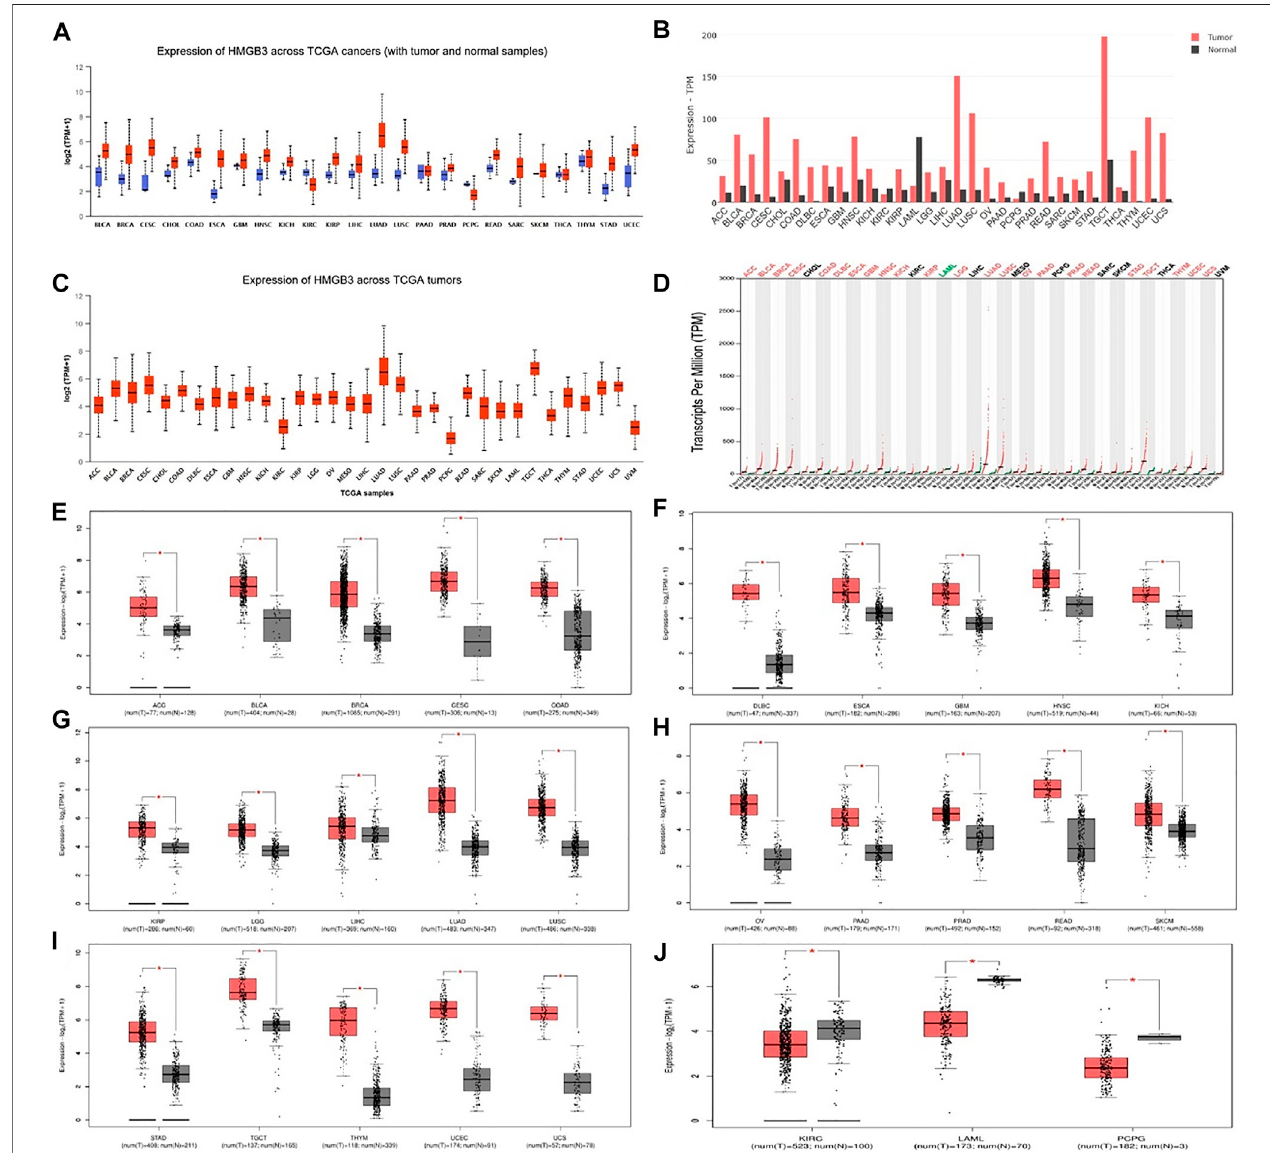
FIGURE 1 | mRNA expression patterns of HMGB3 in different types of human cancer. (A – C) Results were analyzed with the Ualcan website. (B – D) Results analyzed with the GEPIA2 database. (E – J) The expression levels of HMGB3 mRNA in tumor tissues and normal tissues were analyzed based on the GEPIA2 database. * p <